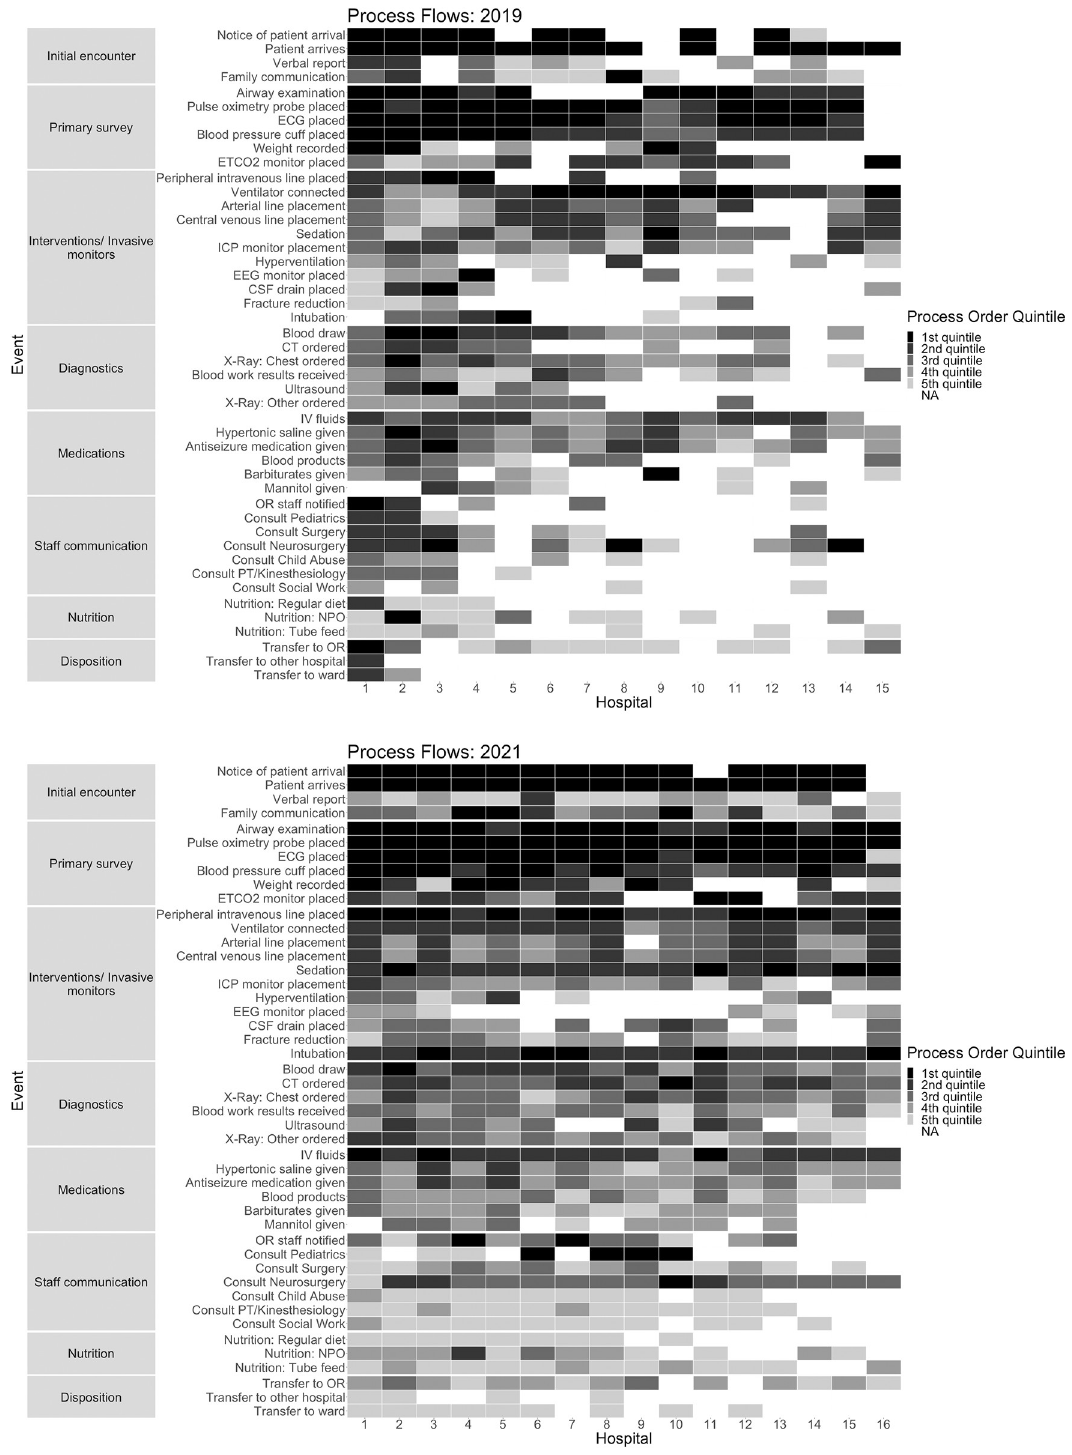
Fig 2. Heat maps of hospital process order in severe pediatric traumatic brain injury care in 2019 (a) and 2021 (b). Hospitals on x- axis. Events grouped by category on y-axis. Raw survey data for each hospital ranked in sequential order to account for survey responses that skipped steps. Ties reported as the same rank with subsequent rank numbers accounting for the number of ties. Rank order batched into quintile order for each hospital. Box grayscale = order quintile of each event for a hospital. Empty boxes = events not included in a hospital’s survey response. ECG = electrocardiogram. ETCO2 = end tidal carbon dioxide. ICP = intracranial